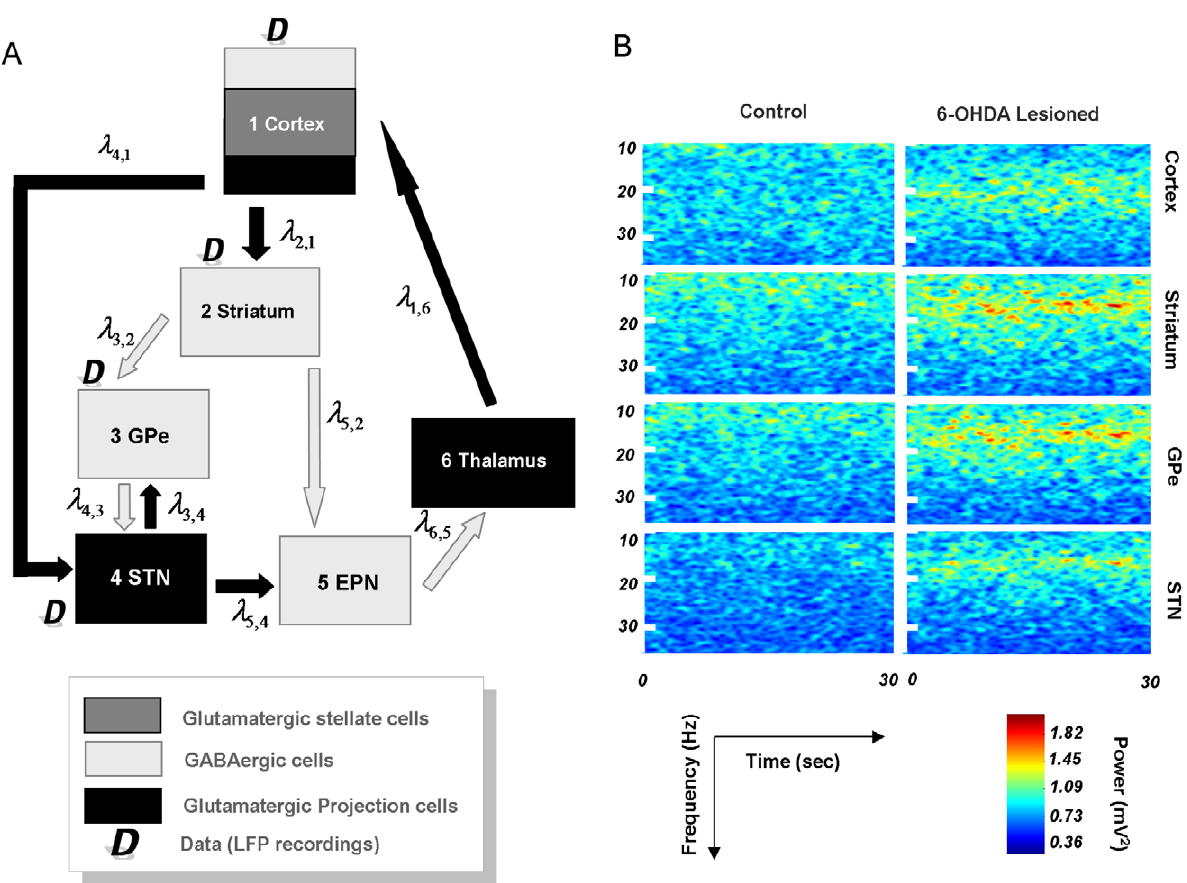
Figure 1. Structure of dynamic causal model and spectral data. (A) The structure of the DCM encompasses the principal nodes and connections in the rodent cortico-basal ganglia-thalamocortical loop. The nodes include a cortical source, 1 , modelled by a three subpopulations corresponding to excitatory input (glutamatergic spiny stellate) cells, projection (glutamatergic pyramidal) cells and inhibitory (GABAergic) interneurons. Excitatory projections from cortex innervate the Striatum 2 , and STN, 4 (the hyperdirect pathway). The Striatum comprises an inhibitory subpopulation that projects to two other inhibitory sources, GPe 3 (as part of the indirect pathway), and EPN 5 (via the direct pathway) with the latter being a BG output nucleus. The GPe and STN express reciprocal connections, and signals from the hyperdirect and indirect pathways are transformed to BG output nuclei via excitatory STN projections to the EPN. The thalamus, 6 , which excites cortex, is itself inhibited by connections from EPN. Data, D , used for the model inversion were acquired from LFP recordings in cortex, Striatum, GPe and STN. (B) Group average spectrogram of LFP data recorded from cortex, striatum, pallidum and subthalamic nucleus. Left Control animals display low power broadband signals across all thirty seconds. Right Parkinsonian animals display high amplitude beta power in all the electrode recordings that extends throughout the